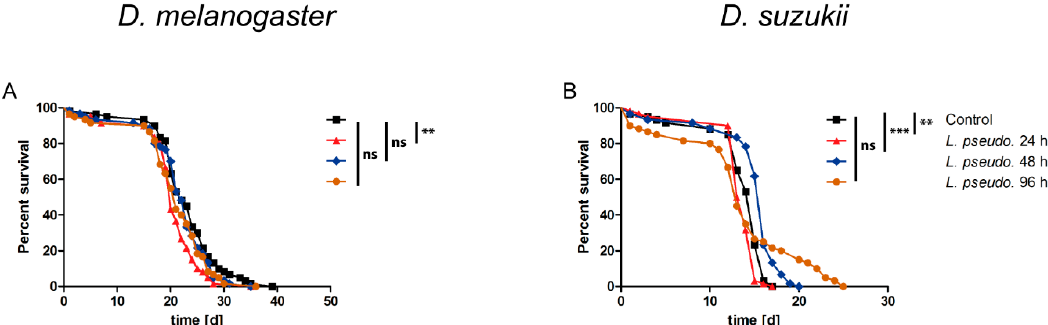
Figure 5. Survival curves for the septic administration of Leuconostoc pseudomesenteroides extracts by the injection of ( A ) Drosophila melanogaster and ( B ) D. suzukii with 4.6 nL of extract prepared after 24, 48 or 96 h, or an extract of sterile culture medium as a control. A logrank test was used for statistical analysis. Each composite graph represents n = 180 flies per treatment, making a total of 720 flies per species. Statistical significance is indicated as follows: p ≤ 0.0009 ***; p ≤ 0.009 **; p ≤ 0.09 *; ns, not significant.